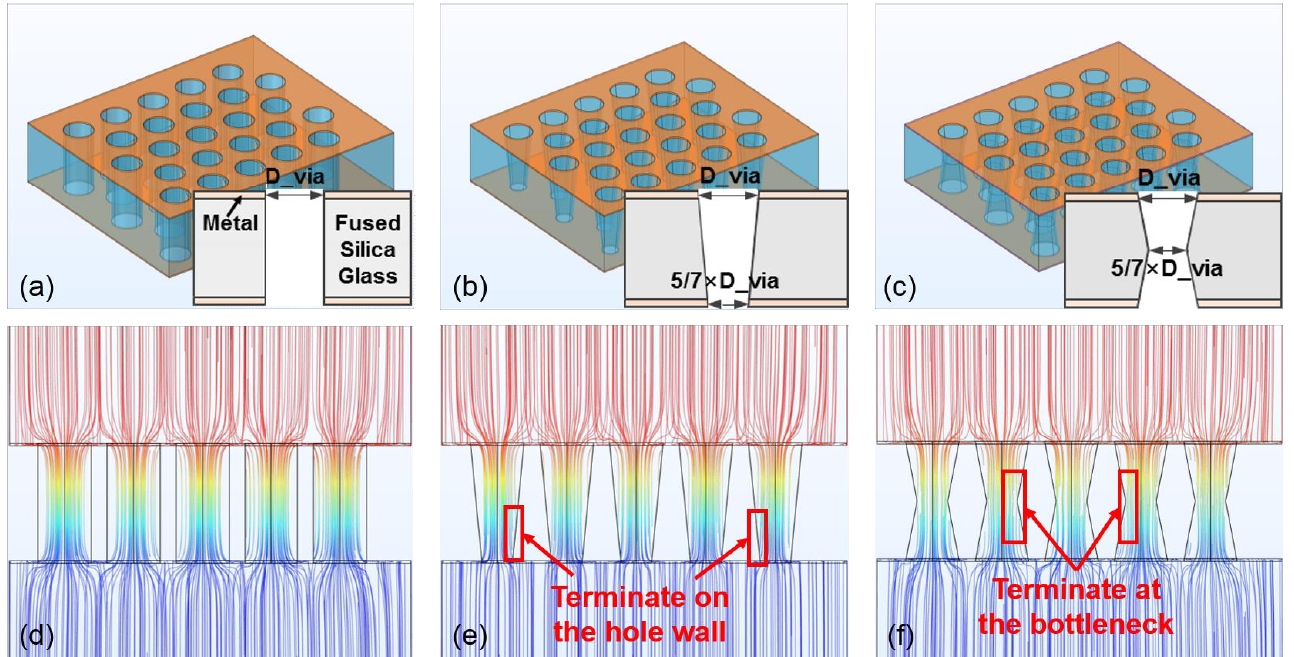
Figure 2. Electric field simulations for different hole structures. Different colors represent different electric potentials. ( a – c ) Three different hole structures: ( a ) straight hole, ( b ) conical hole, and ( c ) double conical hole. ( d – e ) The corresponding electric field distributions in holes of different shapes under the same initial loading conditions. Both ( e , f ) have electric field lines that terminate at the hole walls, which may cause electron attachment, while in straight holes ( d ), the electric field lines all pass through the TGV, extending from above to below the GEM.